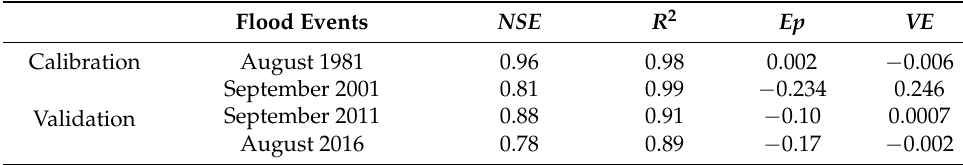
Figure 4. Comparison between the simulated and observed discharges at Ishikari Ohashi station for ( a ) the August 1981 flood event, ( b ) the September 2001 flood event, ( c ) the September 2011 flood event, and ( d ) the August 2016 flood event. Table 2. Statistical indicators of the RRI model